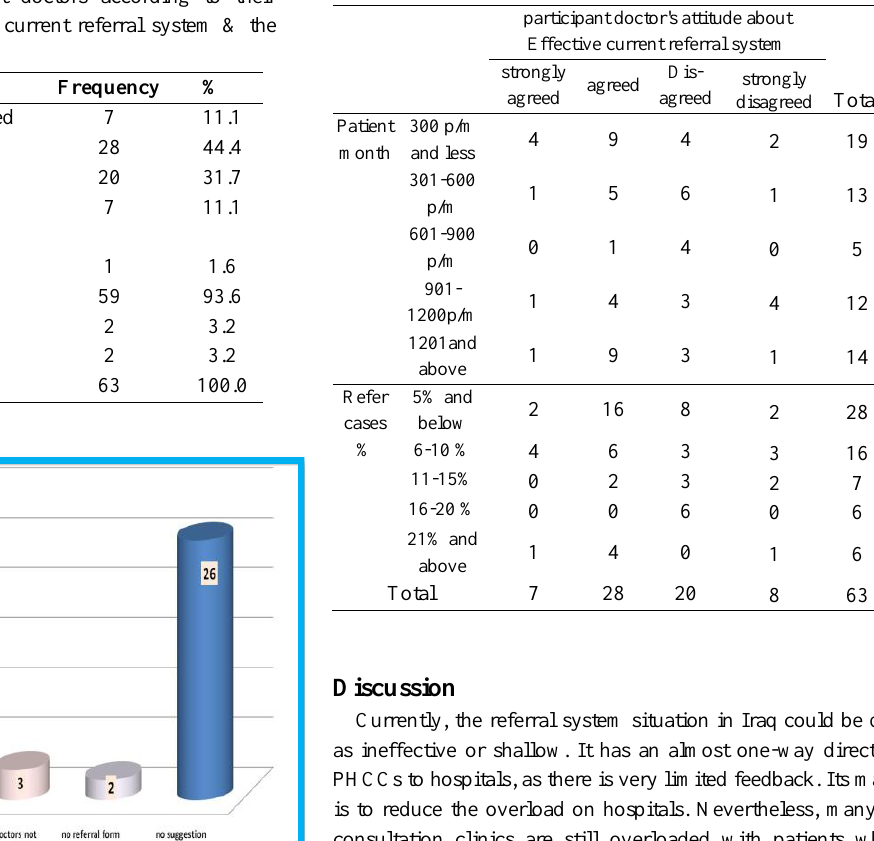
Table 7: Relation between participant doctor's perceptions about Effective current referral system and their Patient / month & Refer cases